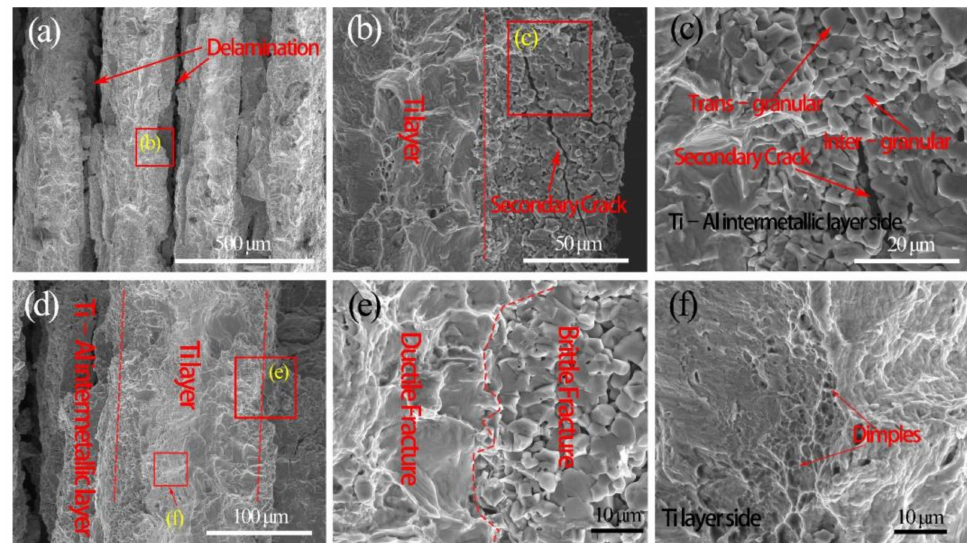
Figure 14. The tensile fracture morphologies of Ti/Ti–Al laminated composite: ( a ) Delamination in the Ti–Al intermetallic layer, ( b ) Secondary Crack in the Ti–Al intermetallic layer, ( c ) Trans–granular and Inter–granular in the Ti–Al intermetallic layer side, ( d ) Interface between Ti–Al intermetallic layer and Ti layer, ( e ) Interface between Ductile Fracture and Brittle Fracture, ( f ) Dimples in the Ti layer side.